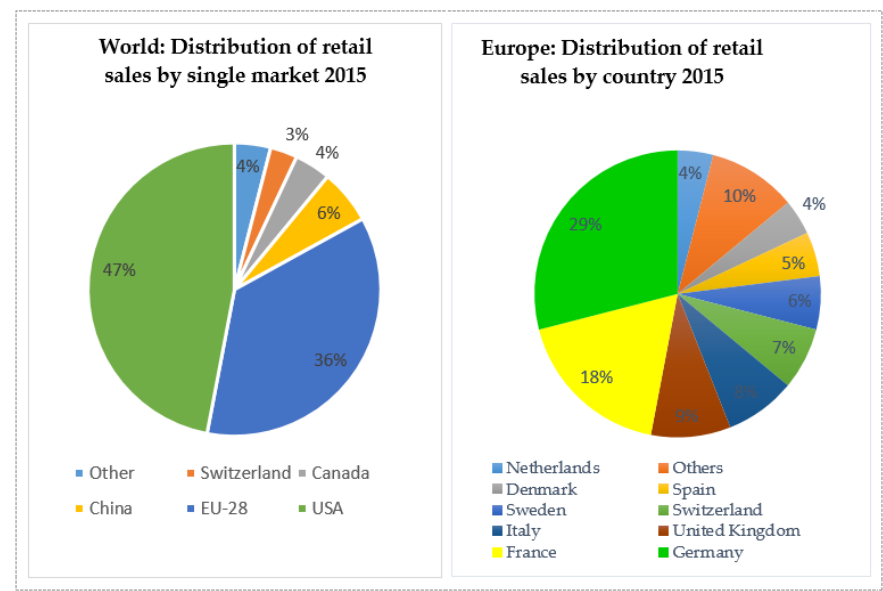
Figure 4. Growth of organic retail sales in Europe and the European Union, 2000–2015 (Billion euros). Source: FiBL-AMI Surveys 2006–2017 and Organic Data Network Surveys 2013–2015.